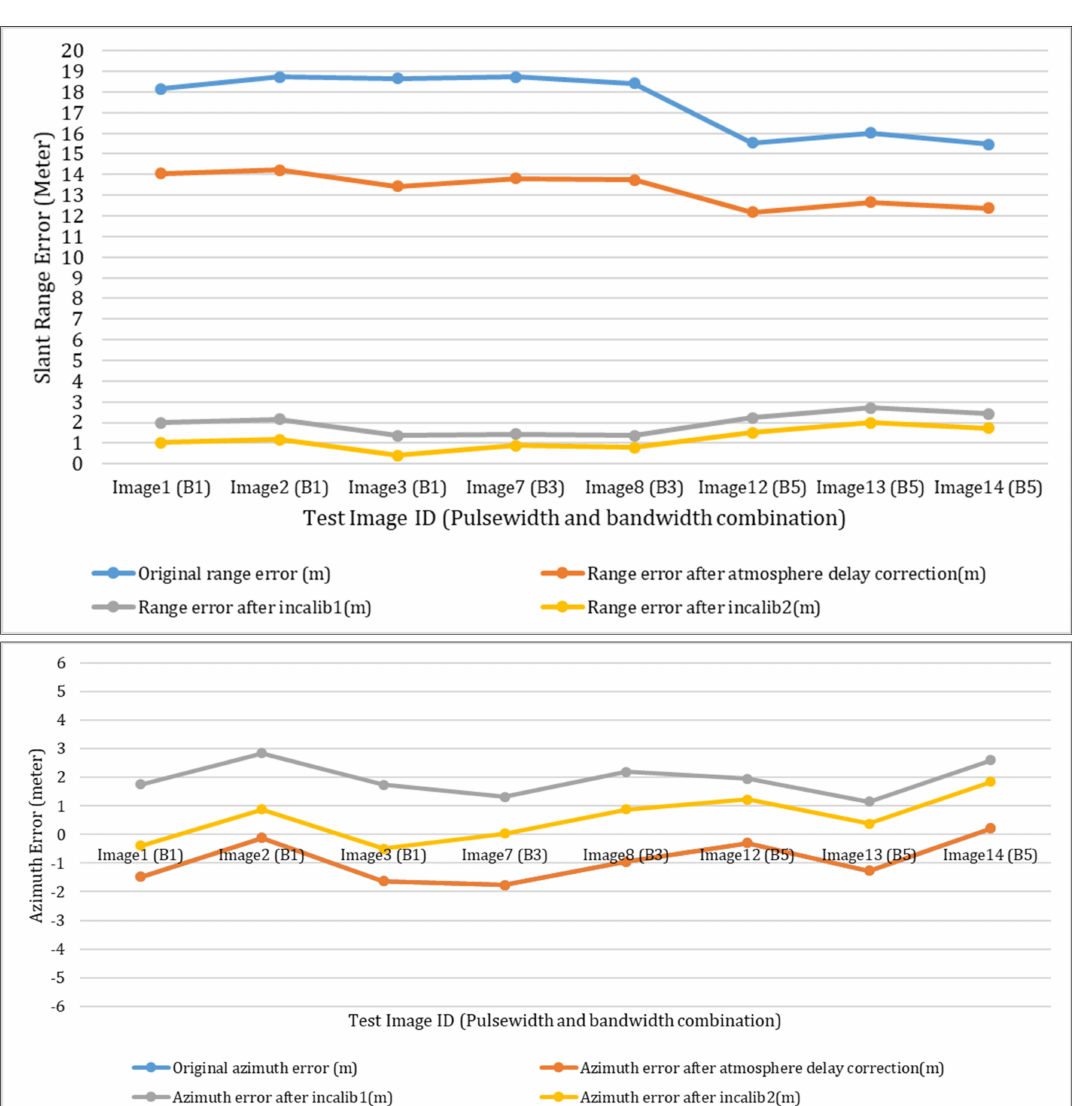
Figure 14. Positioning results of the test images of three groups B1, B3, and B5 (Top: range direction; Bottom: azimuth